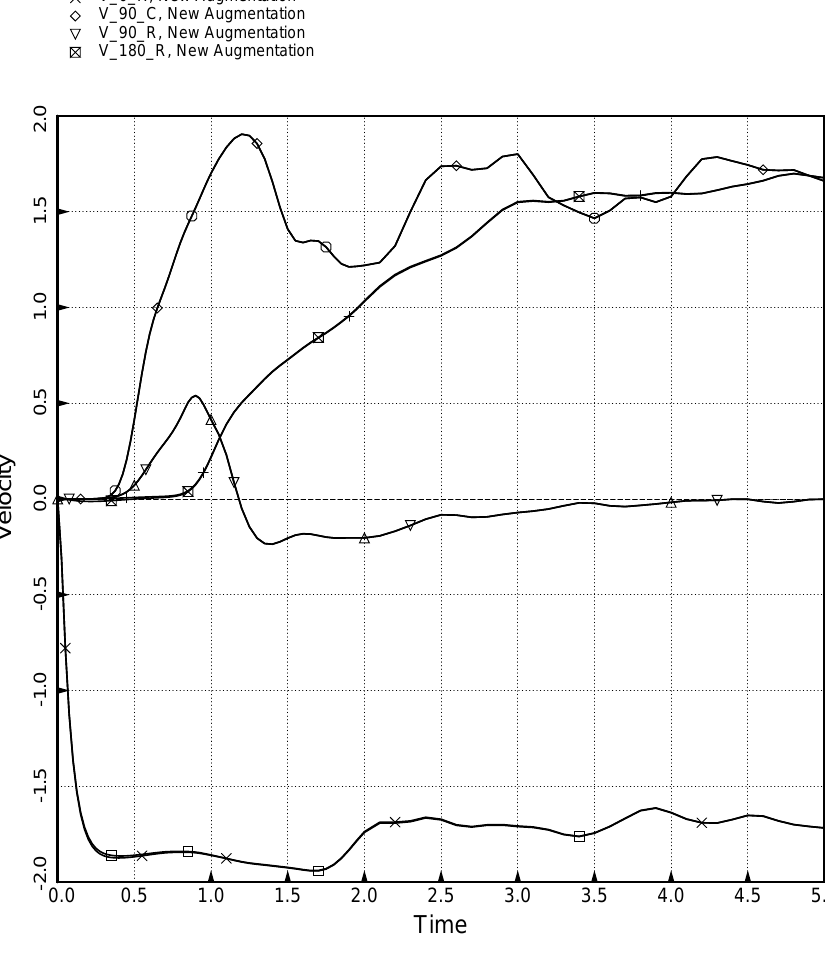
Fig. 2. Cylinder, DAA 2m, Nonsingular